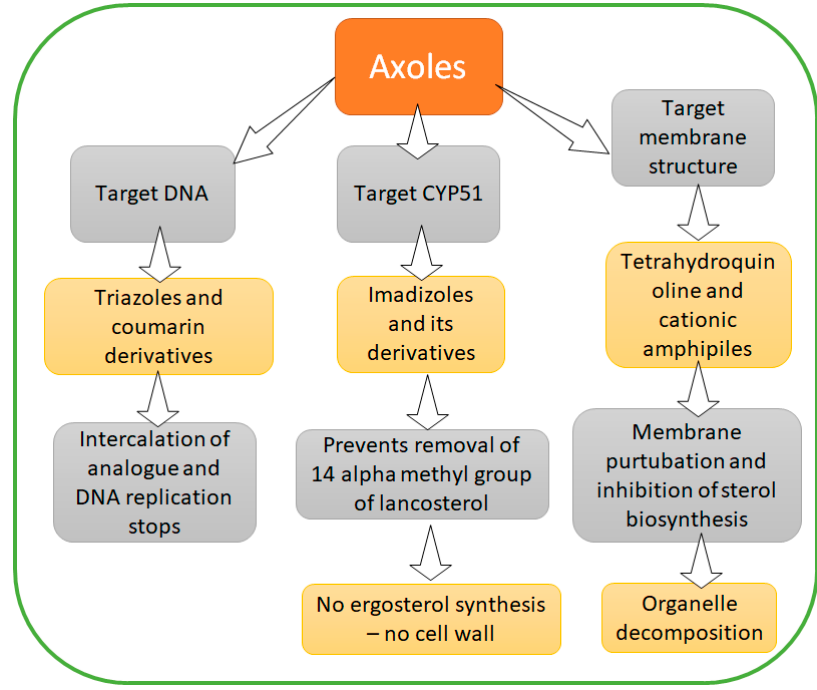
Figure 5. Mechanism of azoles as bio-preservatives.